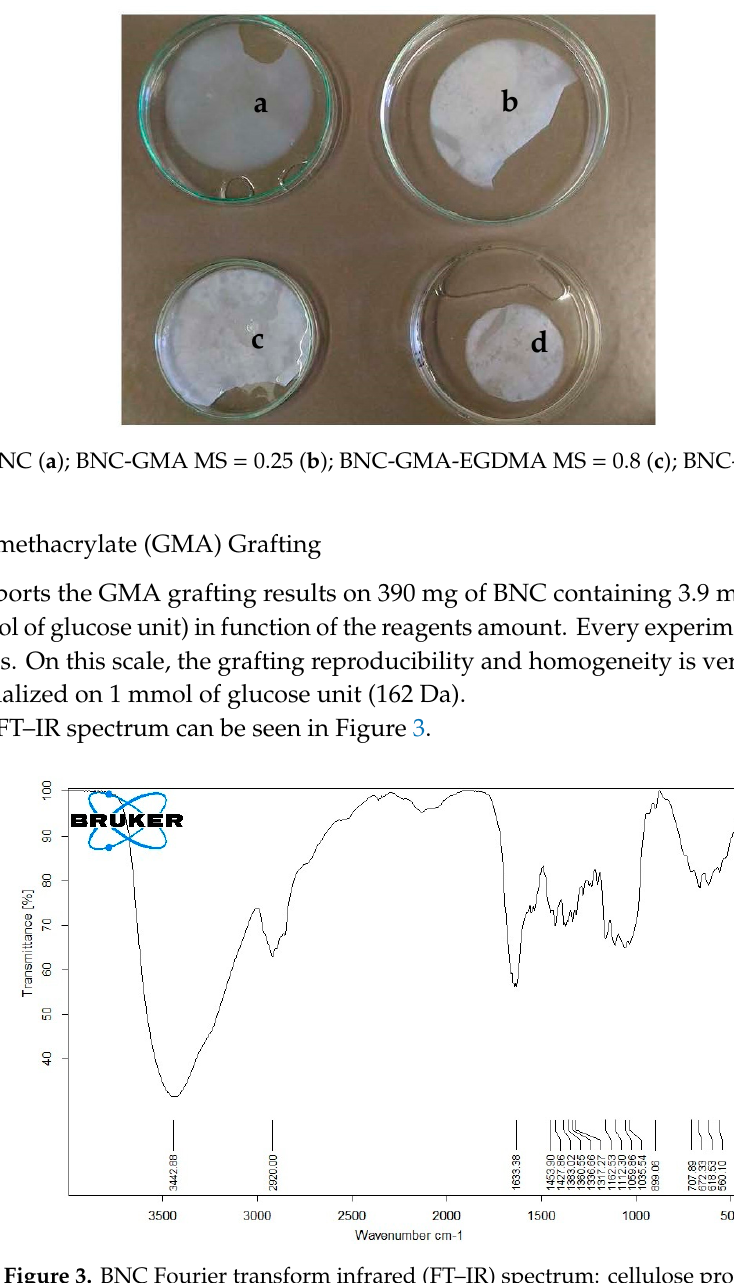
Figure 3. BNC Fourier transform infrared (FT–IR) spectrum: cellulose profile.